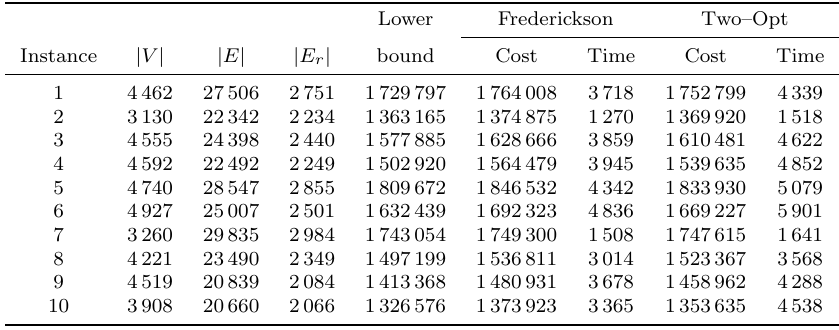
Table 4: Test results for an RPP data set consising of large graphs. Execution times are measured in seconds and were achieved on an Intel Pentium IV processor (2.8 GHz) with 512 Mb